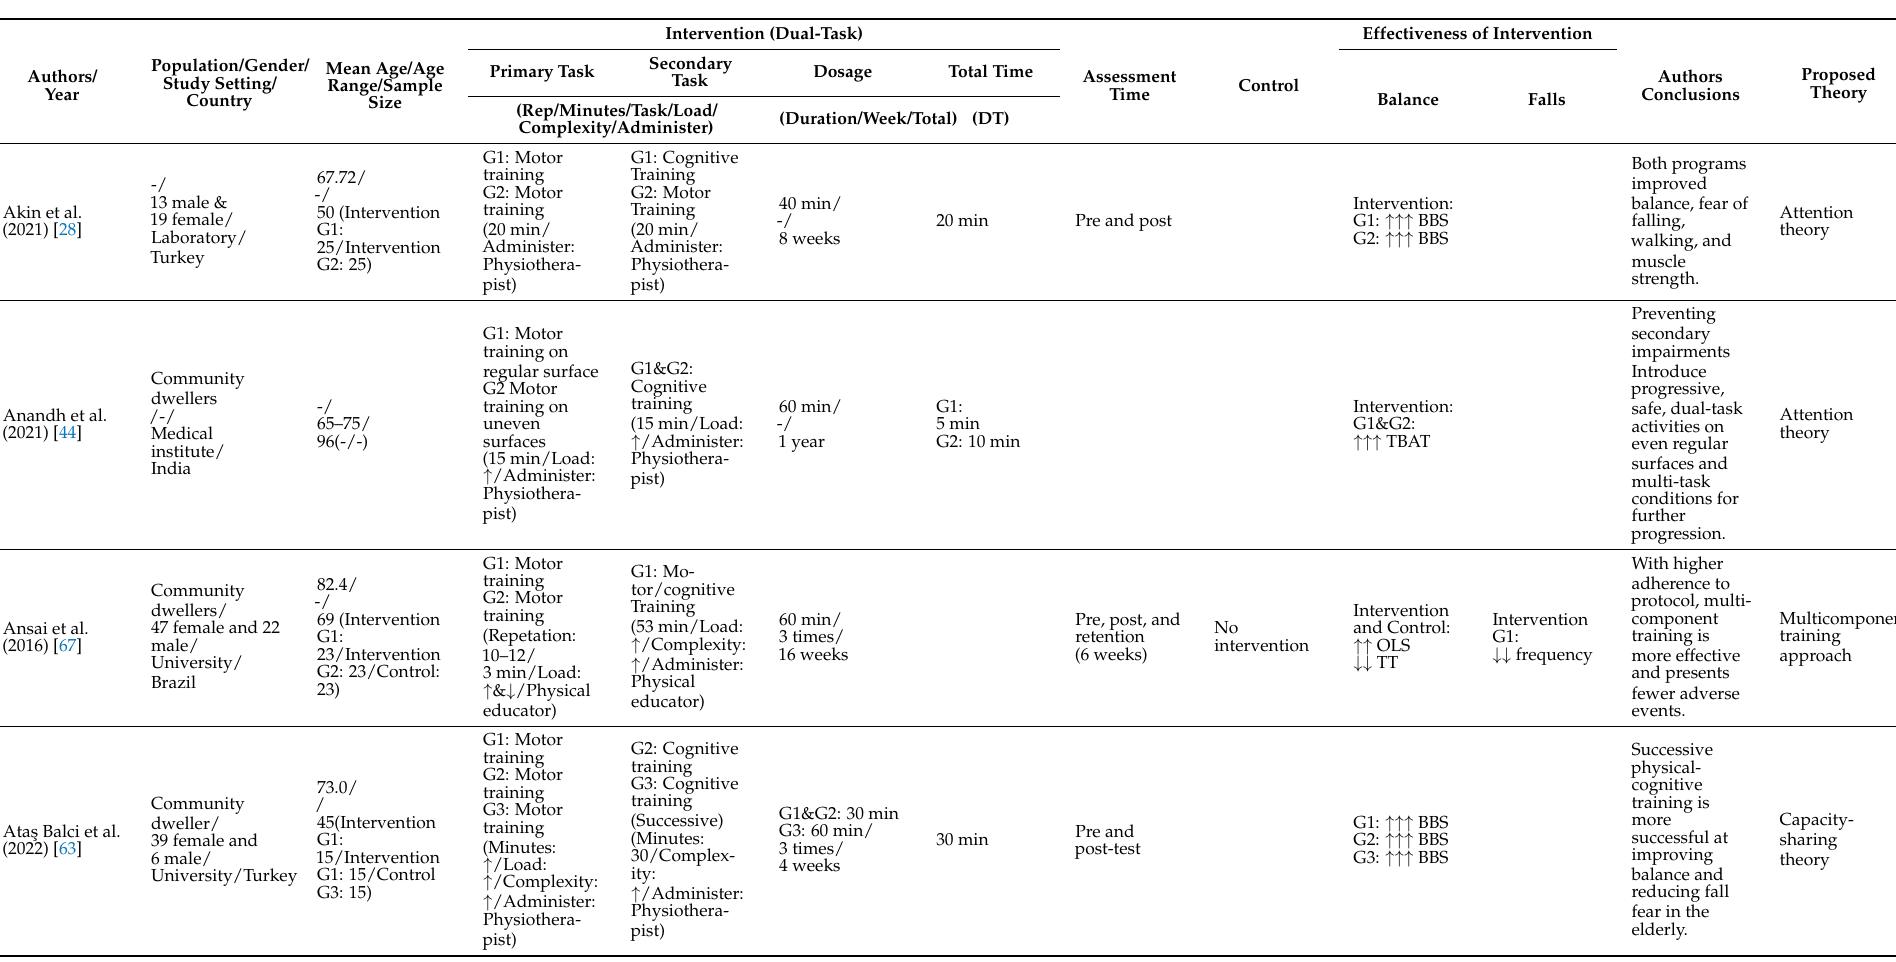
Table 2. Dual-task training and the proposed theory from all included